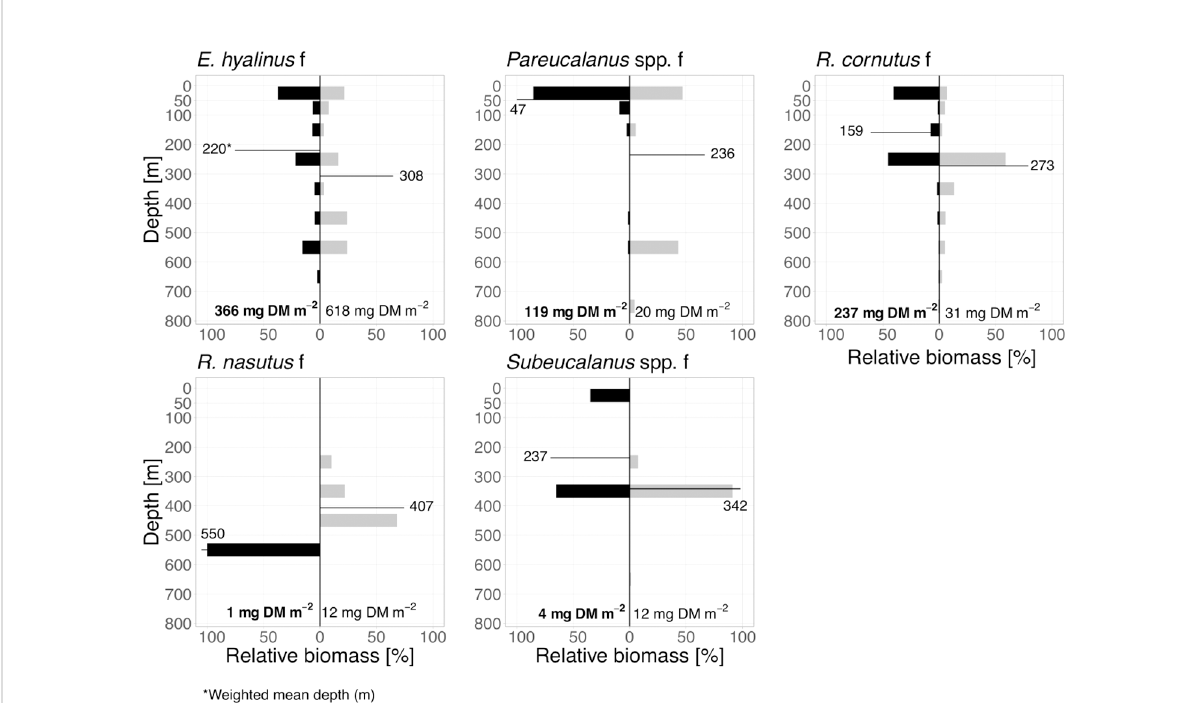
FIGURE 3 “ Thrifty fl oater ” community. Relative biomass distribution for day (grey bars) and night (black bars) of main species within the thrifty fl oater community. Weighted mean depth (m) values for day and night of each group are indicated. Absolute total biomass values (mg DM m -2 ) are added for each taxon below the